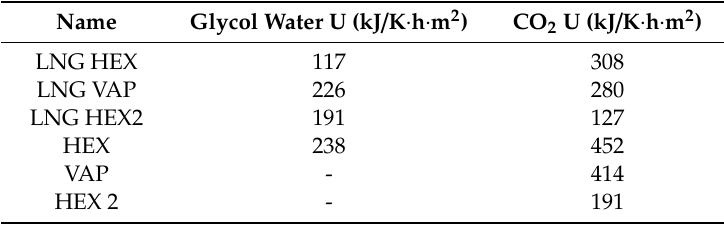
Table 4. Overall heat transfer coefficients for the heat exchanger at optimal conditions.